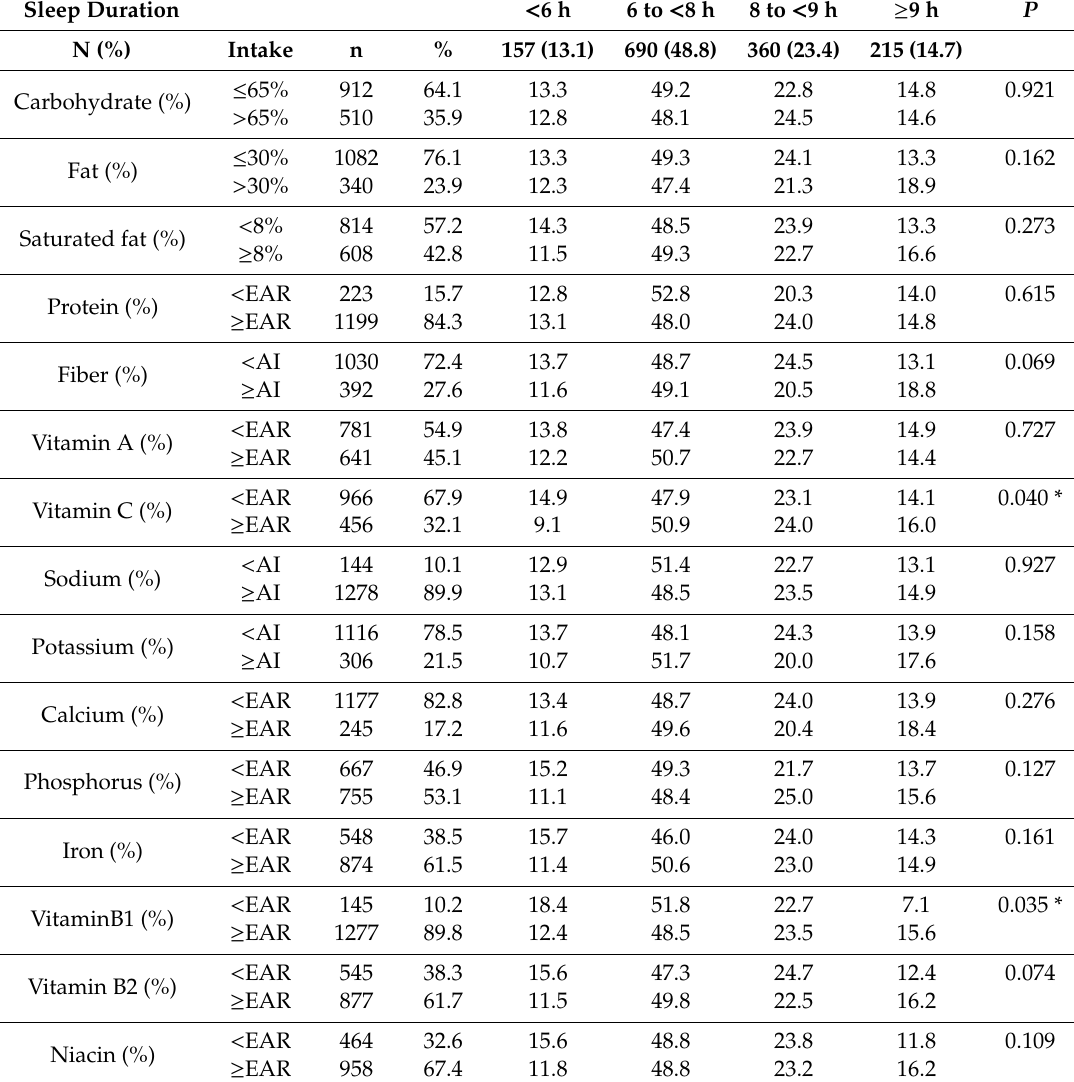
Table 2. Comparison between amount of dietary nutrient intake and sleep